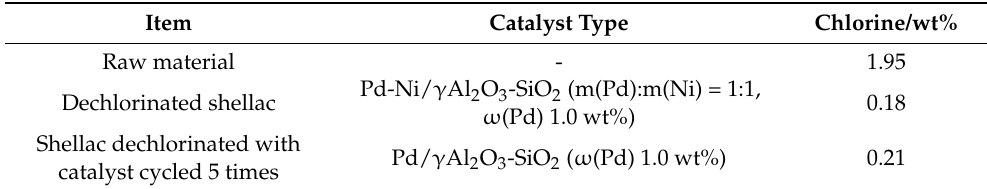
Table 3. Experimental result of the catalytic HDC for shellac by the prepared catalyst. Item